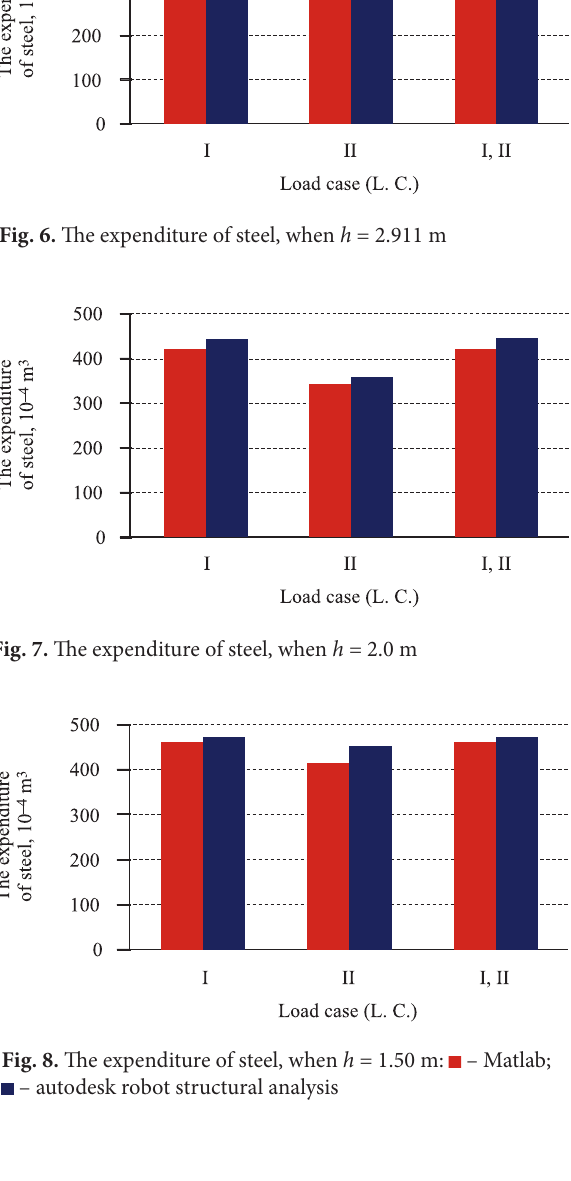
Table 1. Optimization results of the bridge truss Truss height,